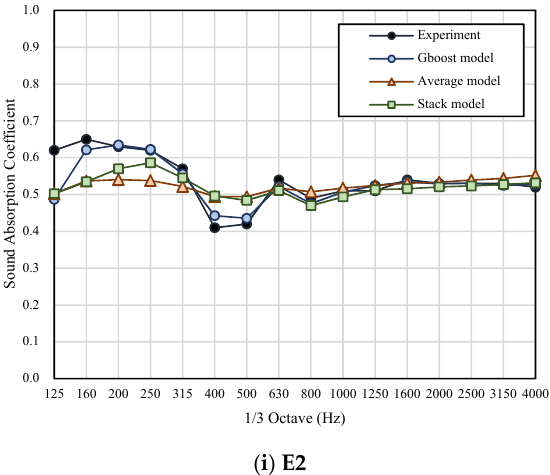
Figure A1. Prediction Results of the ML Model.